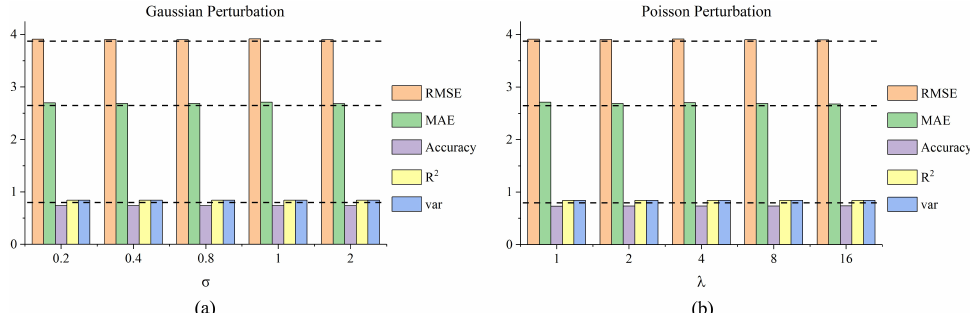
Figure 6. SZ-taxi: Perturbation analysis. ( a ) The performances of the A3T-GCN after adding Gaussian perturbation to the SZ-taxi dataset. ( b ) The performances of the A3T-GCN after adding Poisson perturbation to the SZ-taxi dataset.